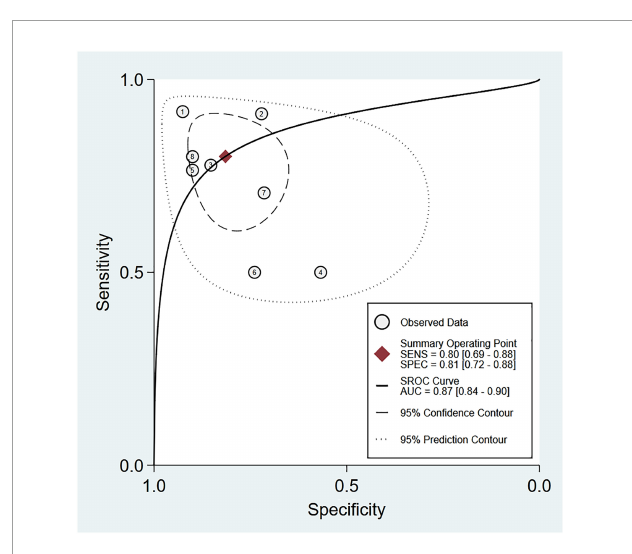
publication bias ( p = 0.26; Figure 6